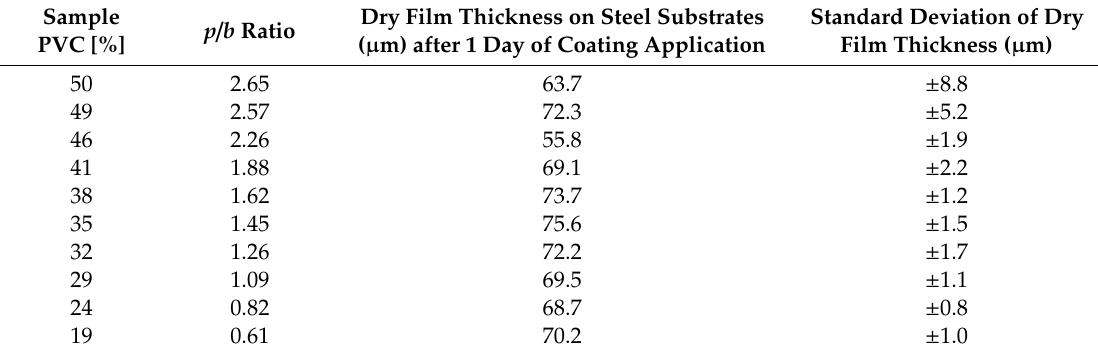
Table 2. Dry film thickness and pigment-binder ratio of epoxy polyamine protective system samples.